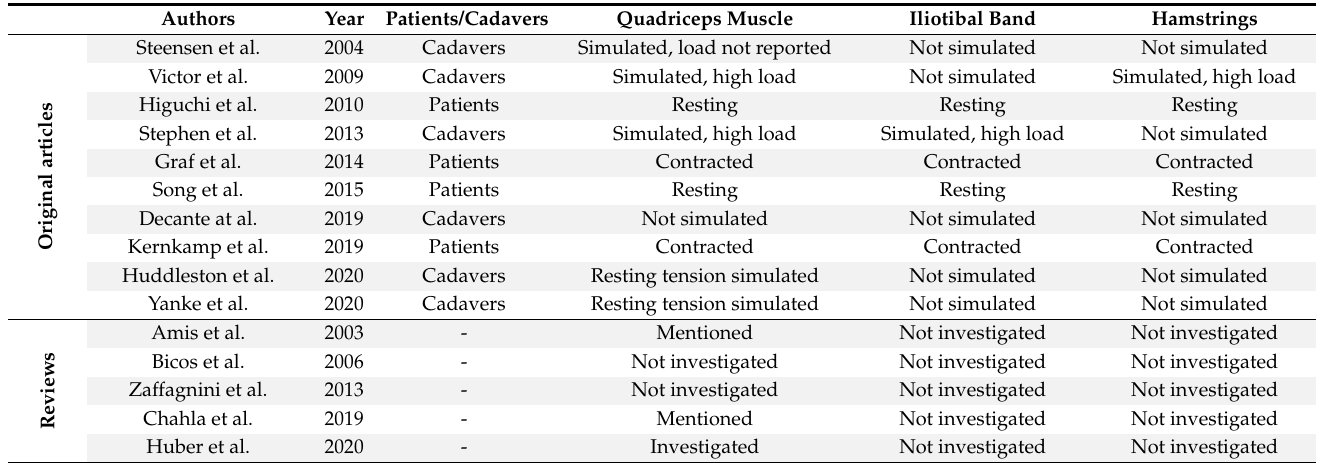
Table 3. Muscular activity within included